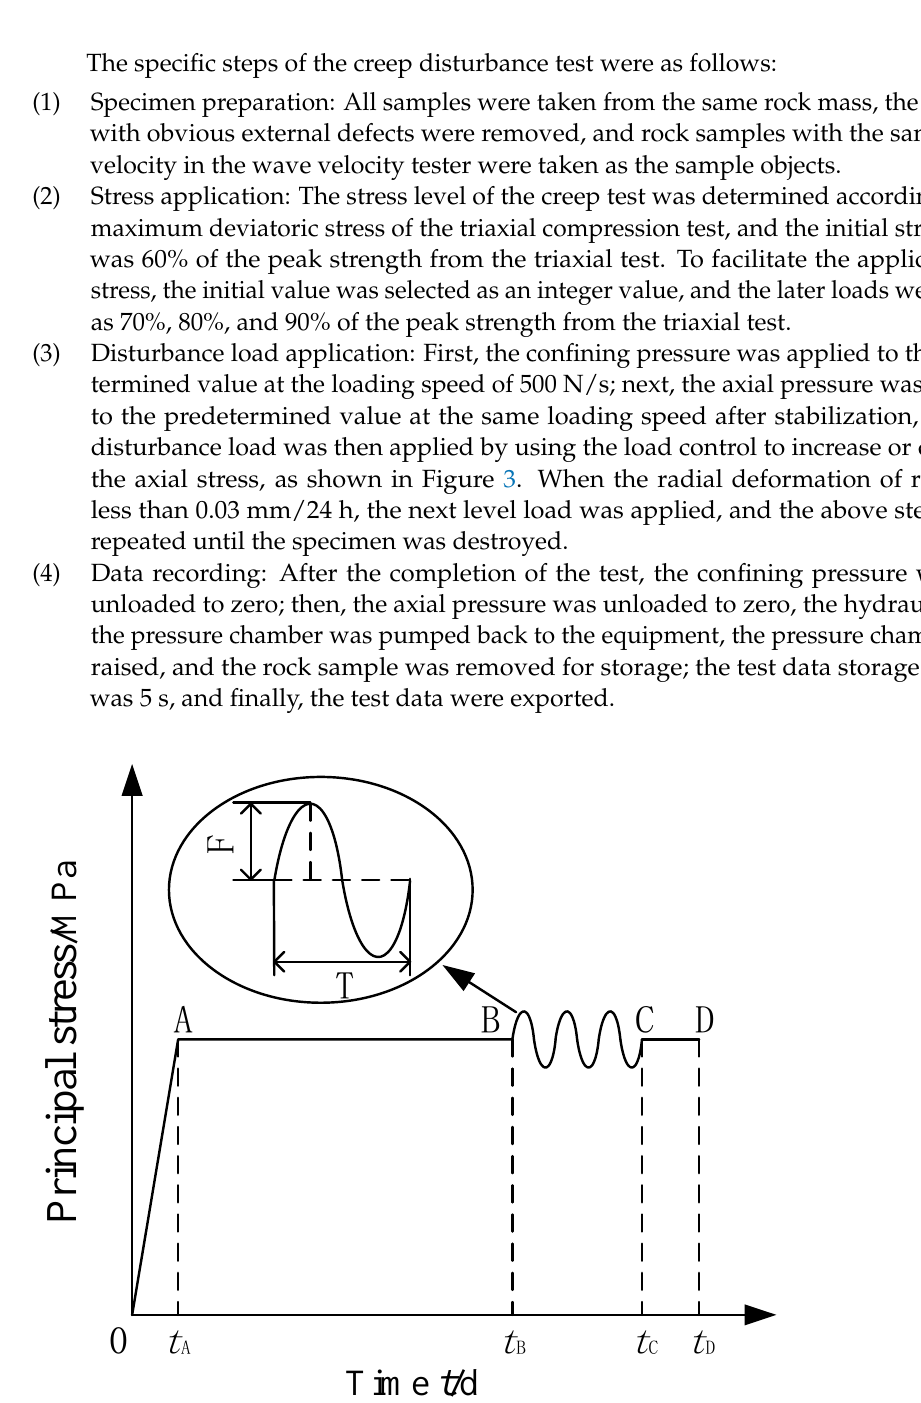
σ 1 loading path Figure 3. σ 1 loading path diagram. Figure 3.